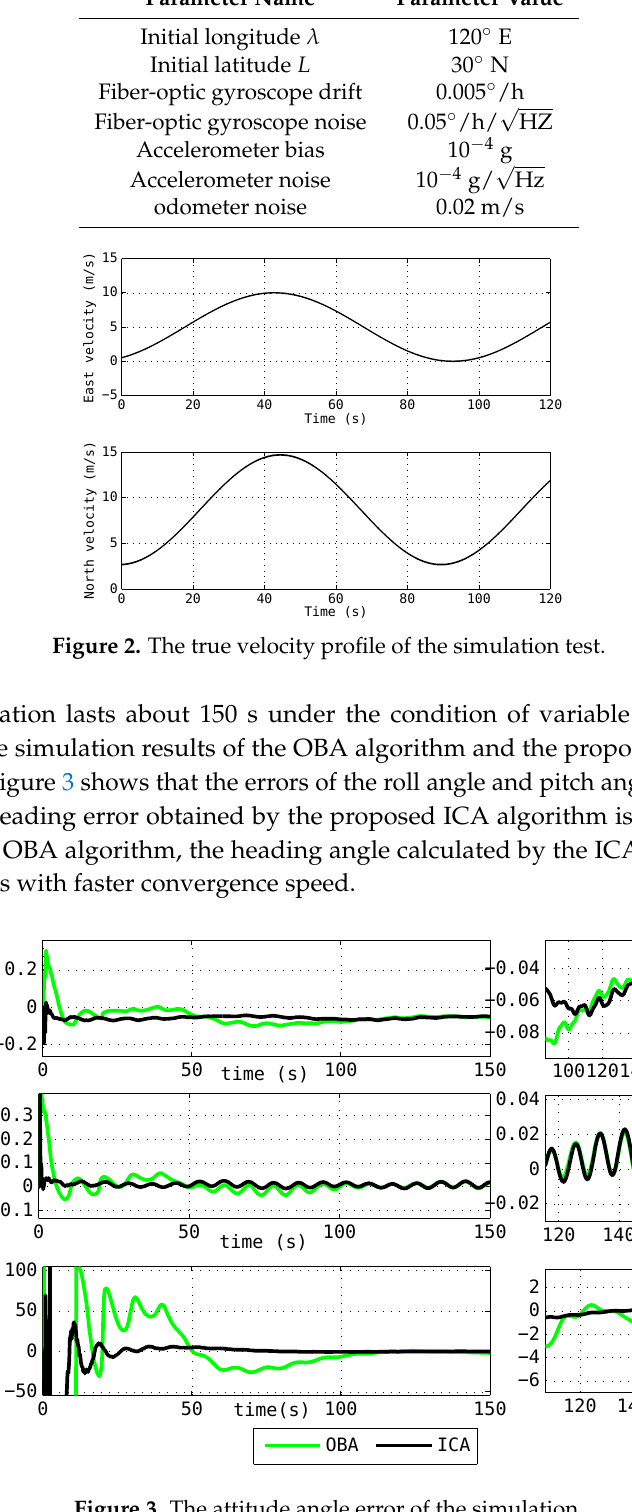
Figure 3. The attitude angle error of the